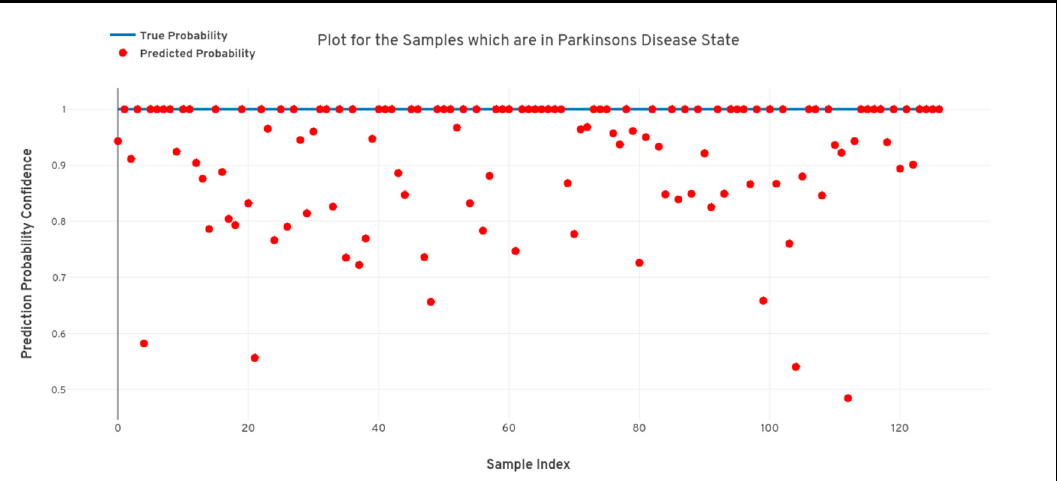
Figure 9. Quantile-quantile plot between the true probability and the prediction probability of the samples belonging to the prodromal class. Probabilistic confidence is 0.641.